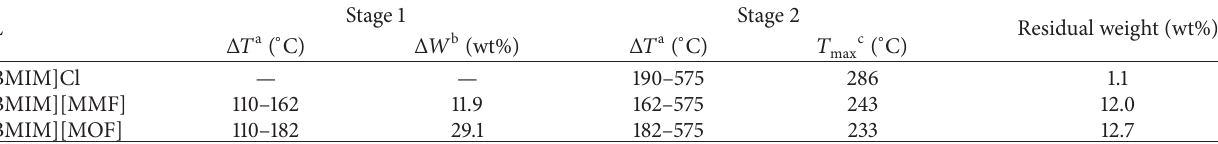
Table 1: Thermogravimetric data for ILs with fumarate anion.